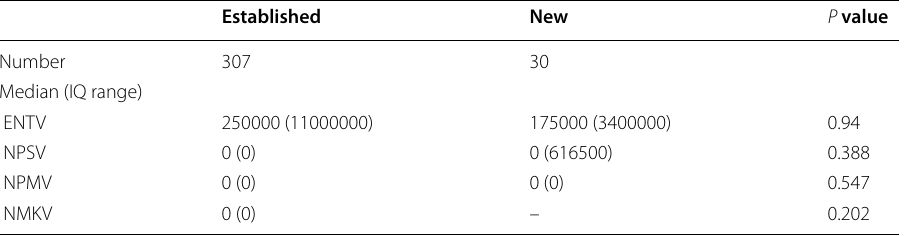
Table 7 Differences between new enterprises and established enterprises in the value of innovations carried